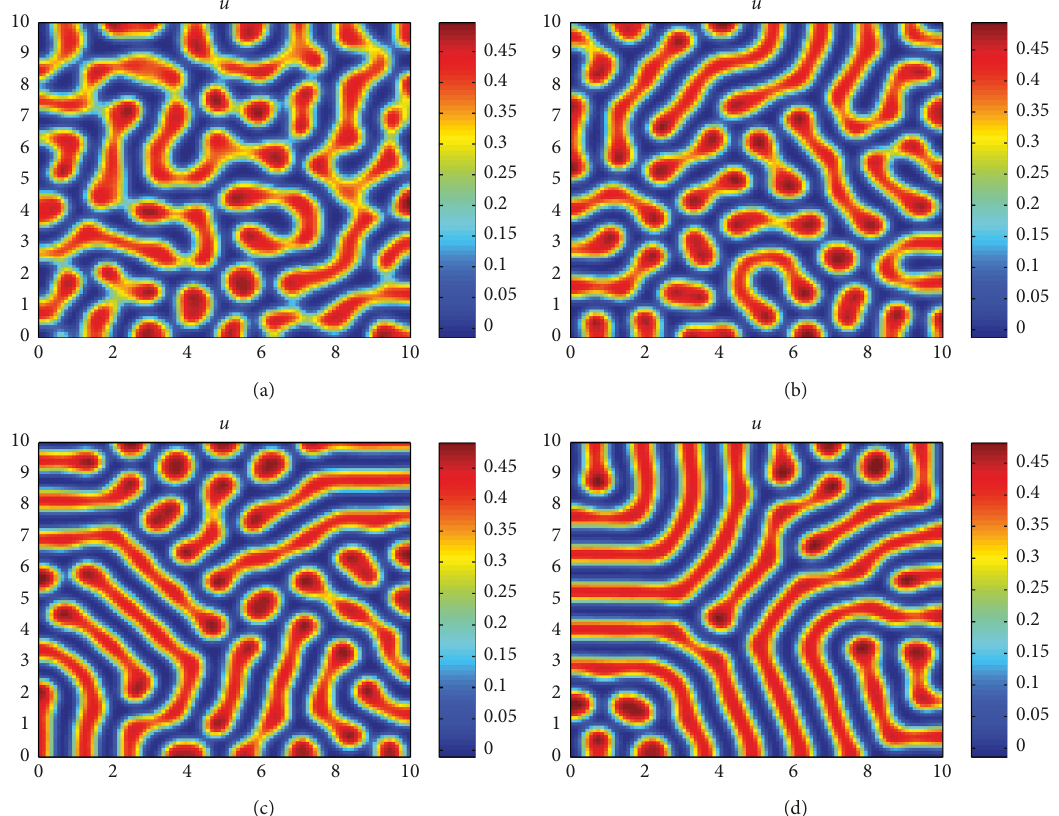
Figure 4: Stripes pattern obtained with model (1) for A � 0 and τ � 0 . 25. Time: (a) t � 100, (b) t � 500, (c) t � 1000, and (d) t � 2000.